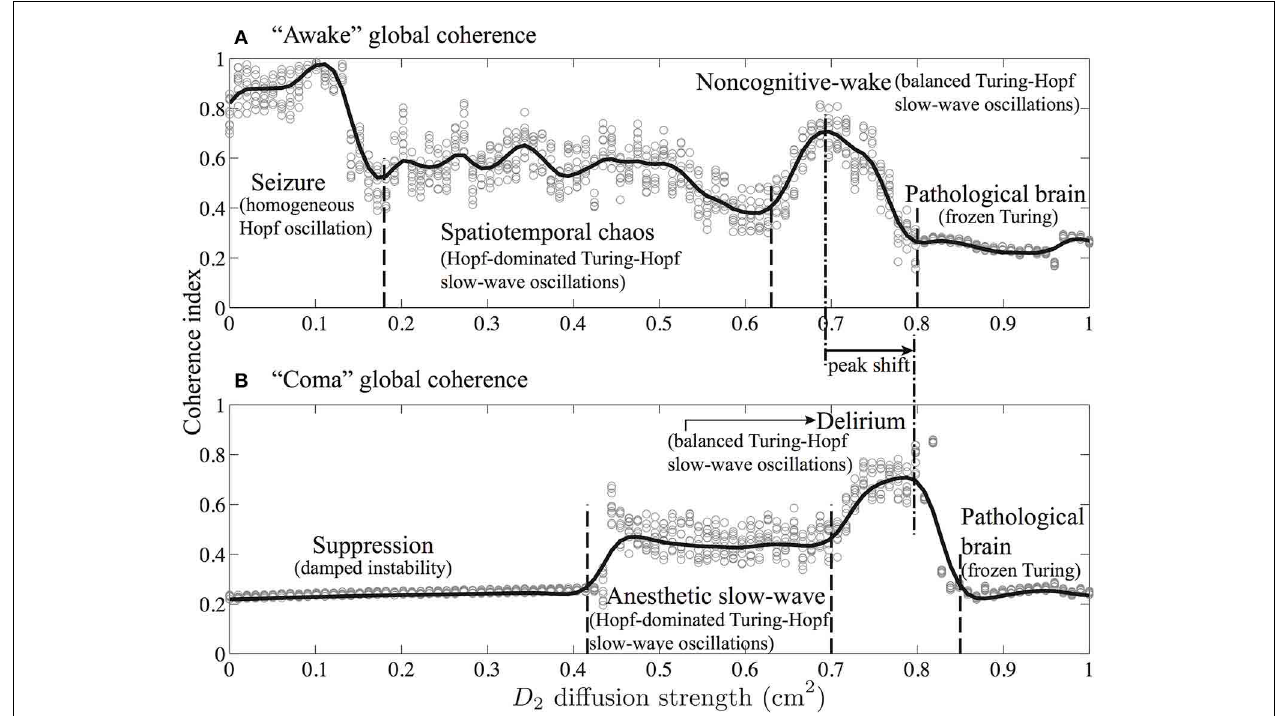
FIGURE 11 | Global phase-coherence trends with respect to inhibitory strength for the cortex at (A) awake ( λ i = 1) and (B) comatose ( λ i = 1 . 018) states. Inhibitory strength D 2 is evenly spaced (0.01cm 2 interval) in the range 0.0–1.0cm 2 . At a given D 2 , simulations were repeated 10 times. For each simulation, we first computed the phase-coherence matrix